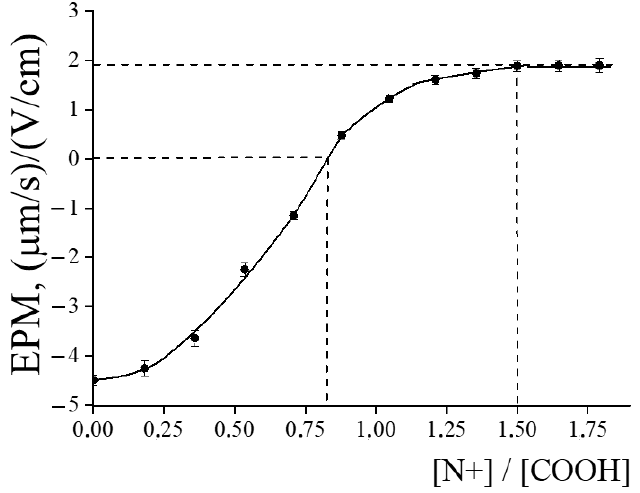
Figure 1. Electrophoretic mobility of BSM–PDADMAC complex particles vs. Z. [BSM] = 4 × 10 − 5 M; 0.01 M phosphate bu ff er with pH 7.